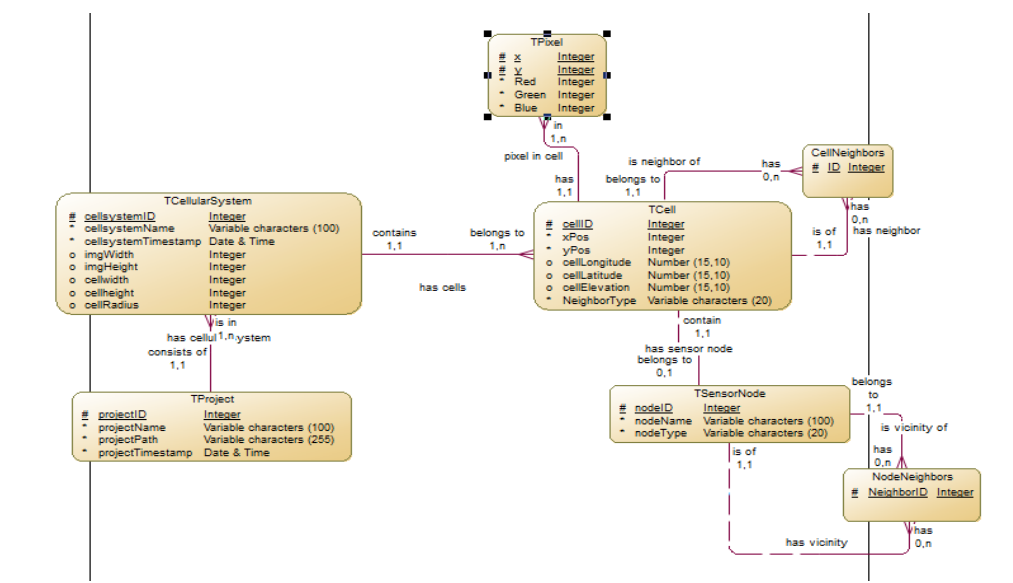
Figure 16. Data modelforbio-environmentalsurveillancenetwork.